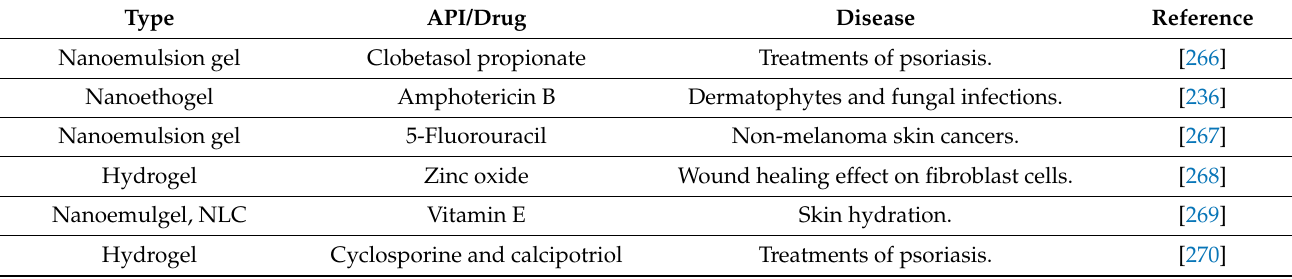
Table 8. Topical nanoformulations used in the treatment of various skin